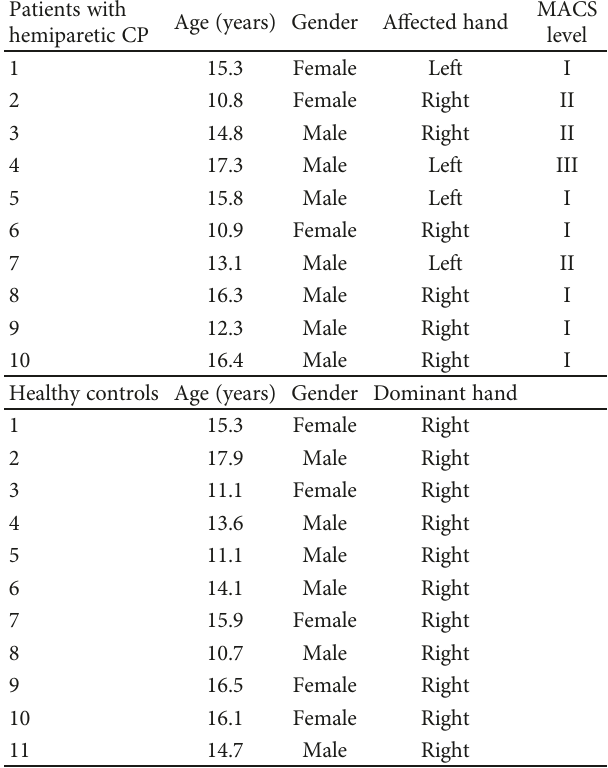
Table 1: Characteristics of patients and healthy controls. Patients